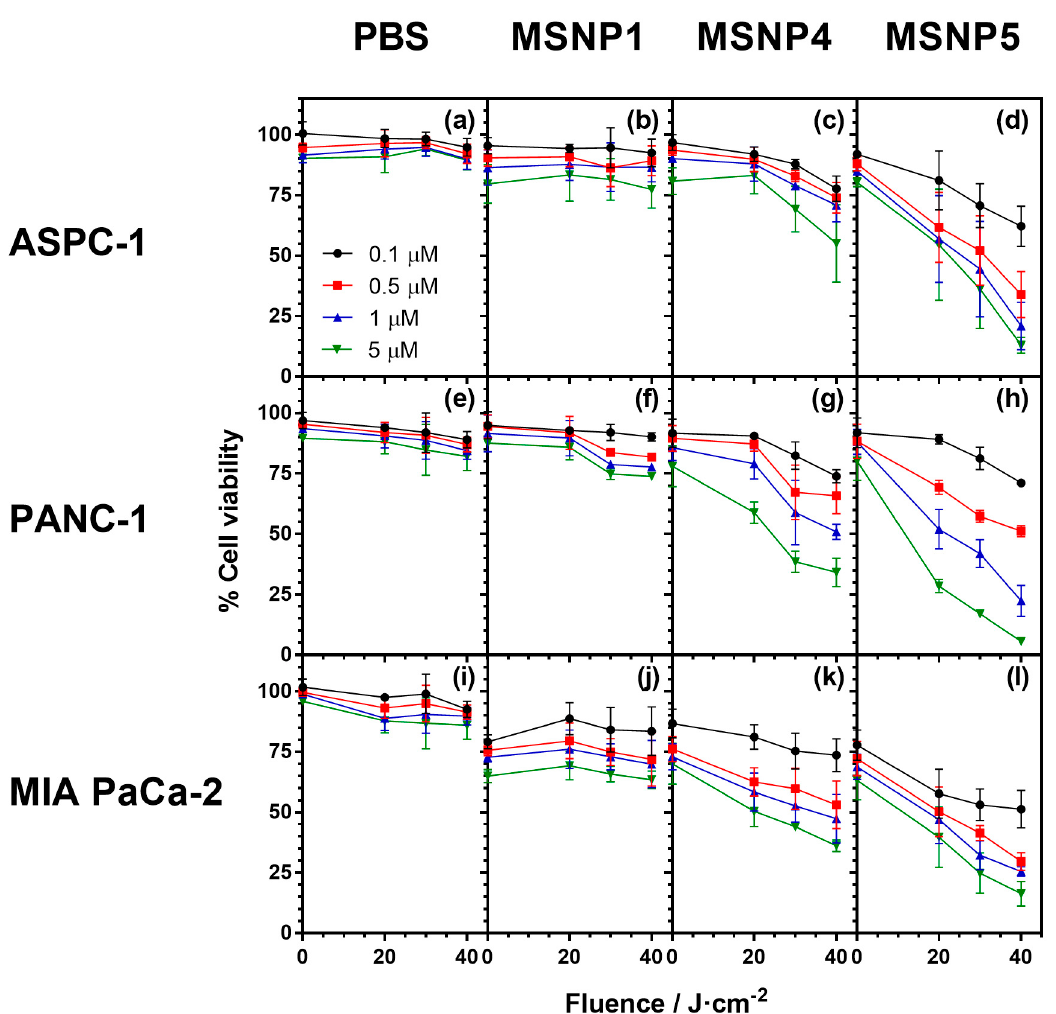
Figure 5. ASPC-1 ( a – d ), PANC-1 ( e – h ), and MIA PaCa-2 ( i – l ) cell viability (expressed as